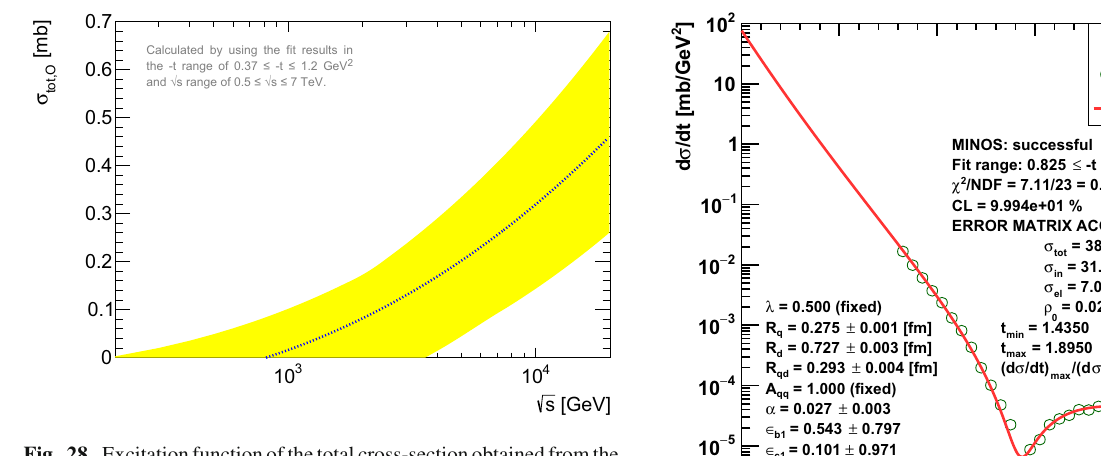
order of magnitude smaller radius, as compared to the effec-